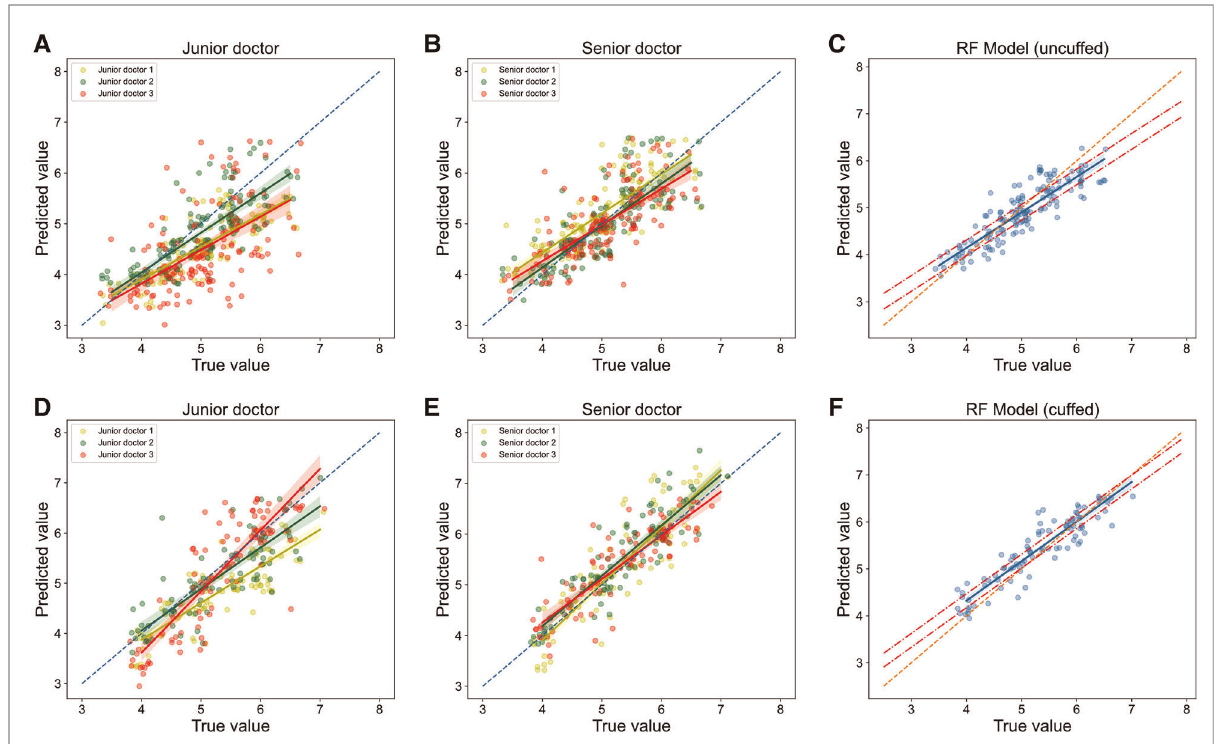
FIGURE 7 Relationship of predicted values and true values in ETT size prediction (models vs. Clinicians) . The scatter plots show the the relationship of optimal ETT size (x-axis) vs. predicted ETT size (y-axis) for uncuffed ETT ( A-C ) and cuffed ETT ( D-F ) size prediction with jonior clinicians ( A, D ), senior clinicians ( B, E ) and RF models ( C, F ). RF=random forest.